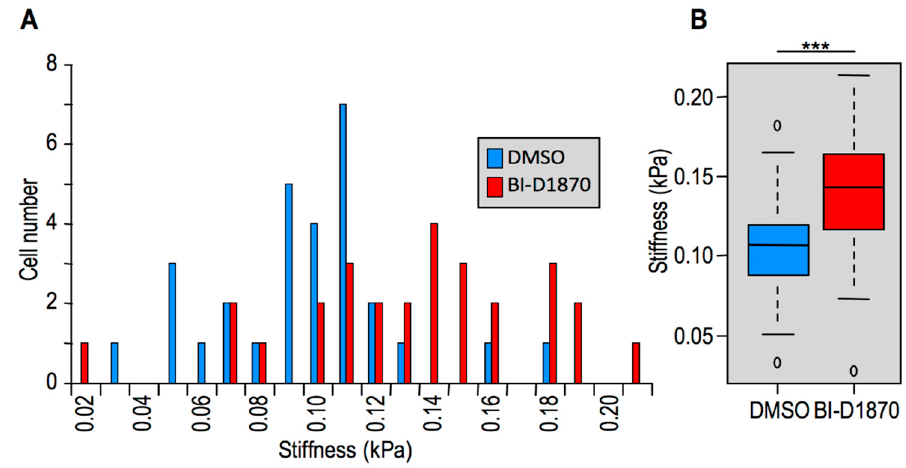
Figure 1. Cells undergoing mesenchymal-to-epithelial transition (MET) increase their stiffness. ( A ) Histograms graphs reporting stiffness distributions of the two cell populations analyzed (DMSO 0.05% and BI-D1870 10 µ M). ( B ) Box plot illustrative of median and quantile distributions of the two cell populations (***: p < 0.001).